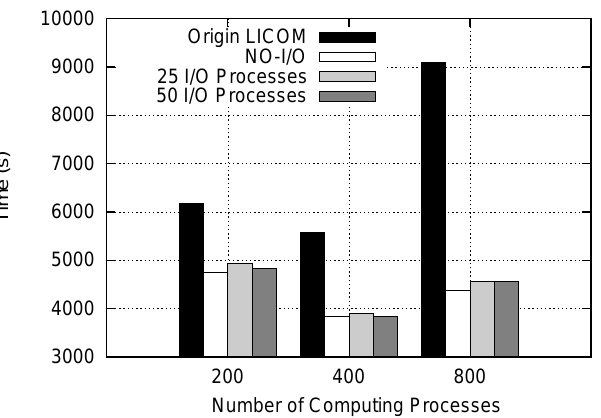
Fig. 9. Throughput comparison of CFIO, PnetCDF and